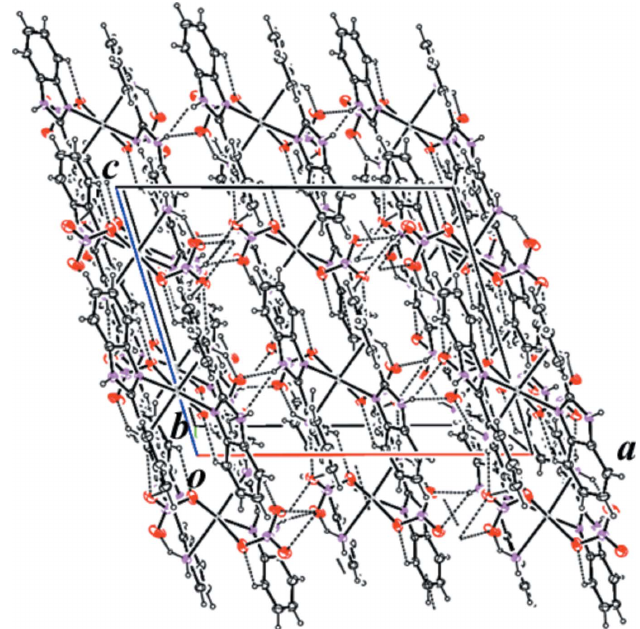
Figure 3 A view along the b axis of the crystal packing of the title compound, showing the three-dimensional network linked of molecules linked by N—H (cid:2)(cid:2)(cid:2) O hydrogen bonds (dashed lines, Table 1).